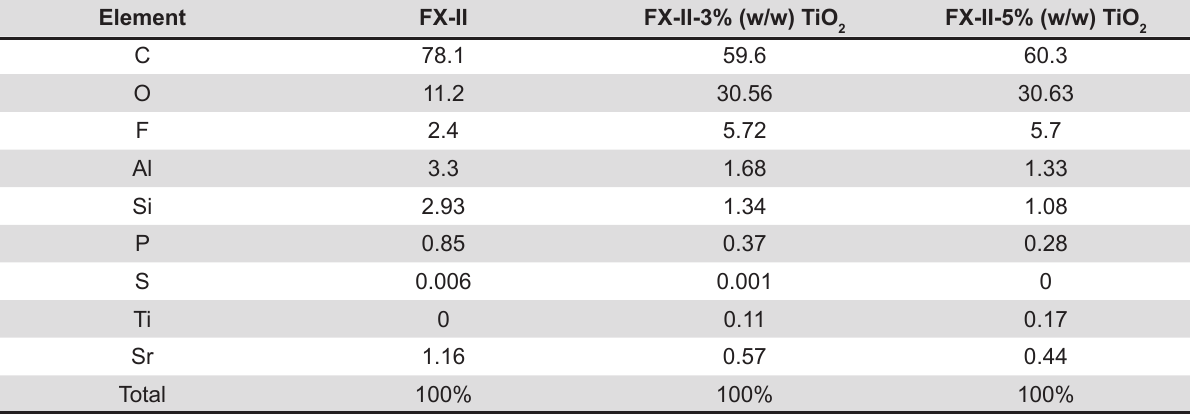
Figure 1- Blocks (4x4x1 mm) of (a) conventional FX-II, (b) FX-II 3% (w/w) TiO were gently polished and finished with #400, #1,000, and #1,500 waterproof abrasive paper and ultrasonically cleaned. Topographically, there are no differences between specimens. Nevertheless, hybrid particles are observed, microparticles (1c, black circle and arrow) are uniformly lay between (matrix) macroparticles, and such particles seem to be grouped of TiO nanoparticles due to their angular and semispherical shape confirmed by the 1d micrograph and EDS of this area, the 2 zone exhibits higher concentration of titanium Table 3- Energy-dispersive X-ray (EDS) analysis of conventional FX-II, FX-II with 3% and 5% (w/w) TiO Values represent atomic percentage (a%)